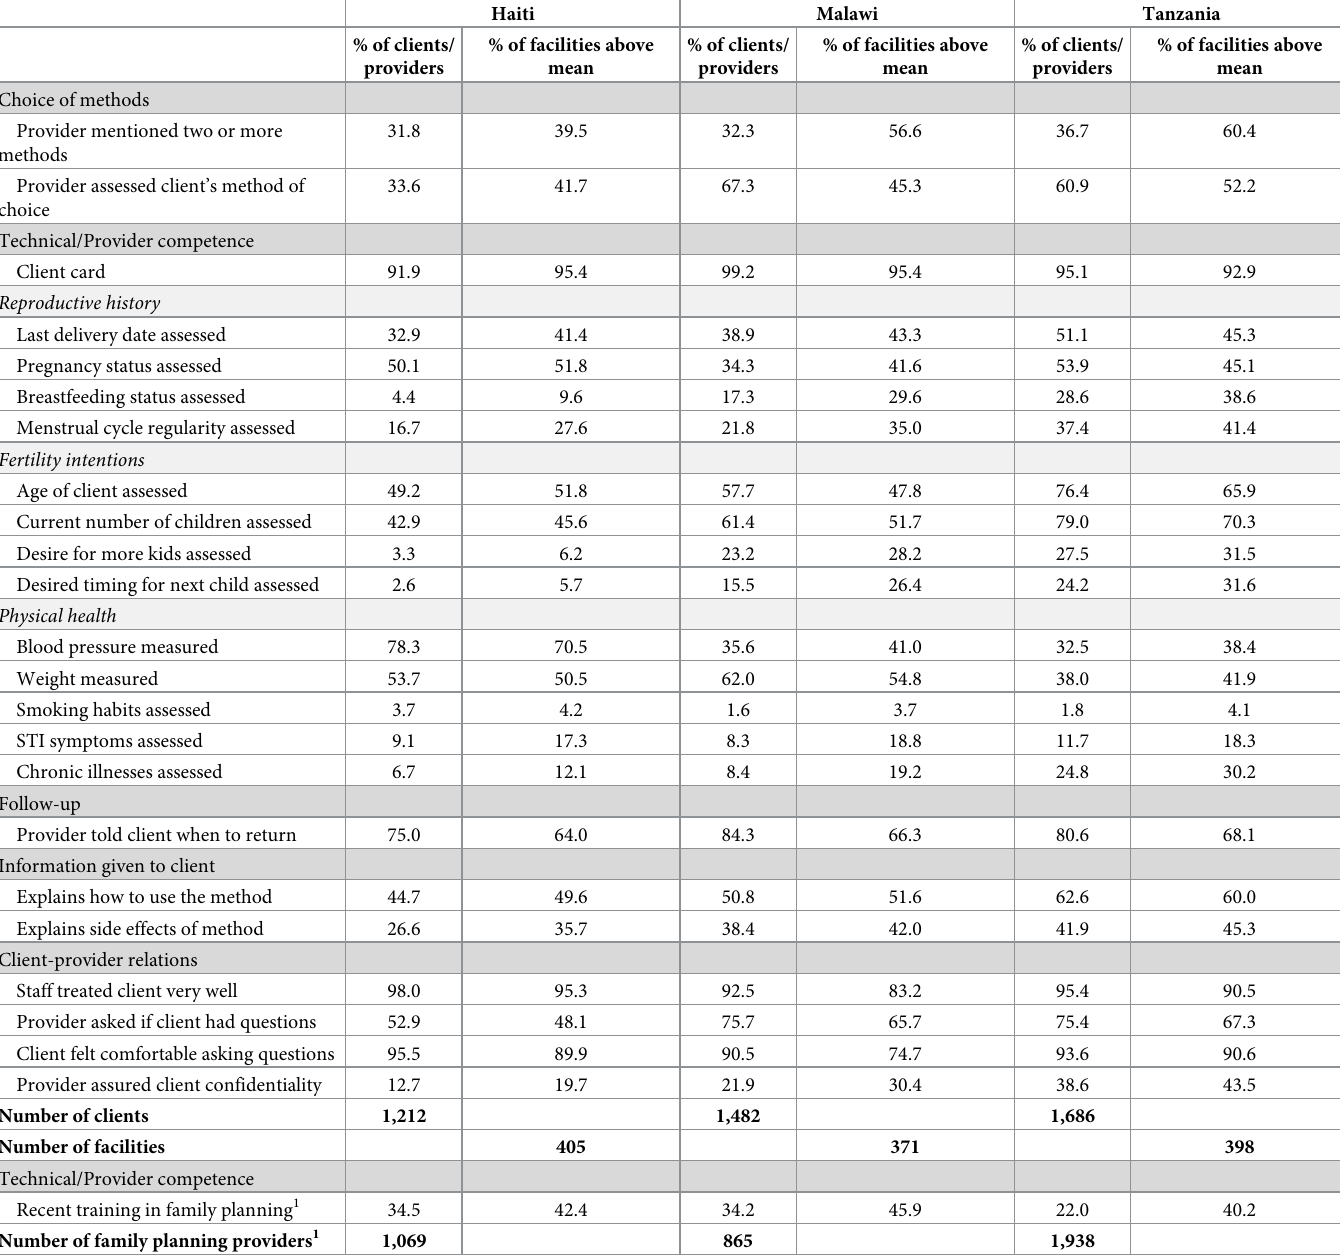
Table 3. Percentage of clients receiving quality of care items, percentage of providers with training, and percentage of facilities with above average reports of pro- cess quality of care